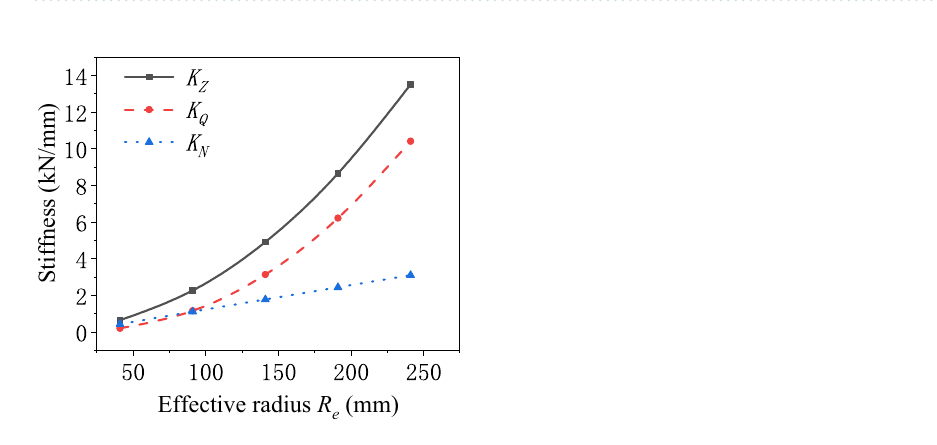
Figure 4. Schematic diagram of the stiffness of the air spring varying with the preload force.